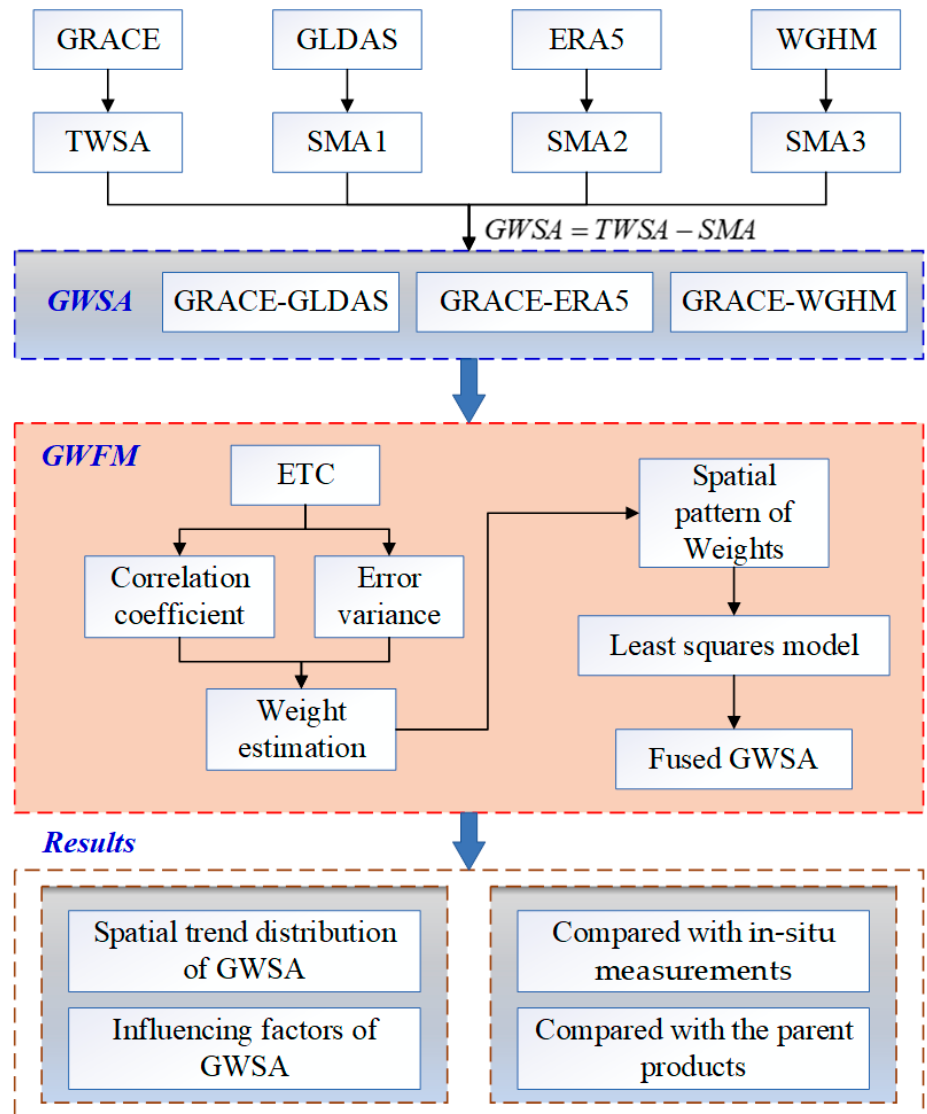
Figure 2. The flow chart of the study.